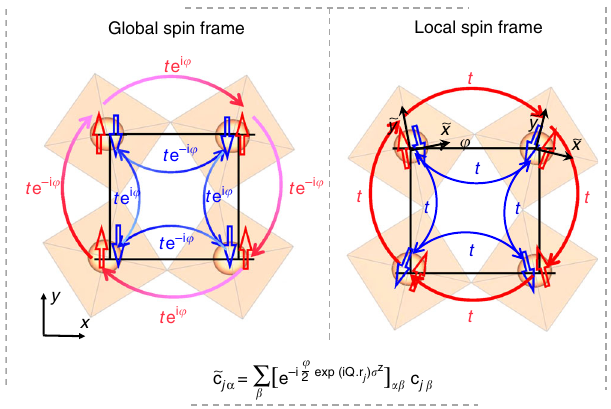
Fig. 3 Charge hopping in spin-up (red) and spin-down channels (blue) in different spin frames. In the global spin frame (left panel), charge hopping bears an alternating phase factor when circling around the square lattice. This phase factor is gauged away in the rotated local spin frame (right panel), leading to an isotropic Hubbard model 27,33 . The annihilation operators ~ c j α , in the local frame are transformed from c j, β in the global frame according to the shown